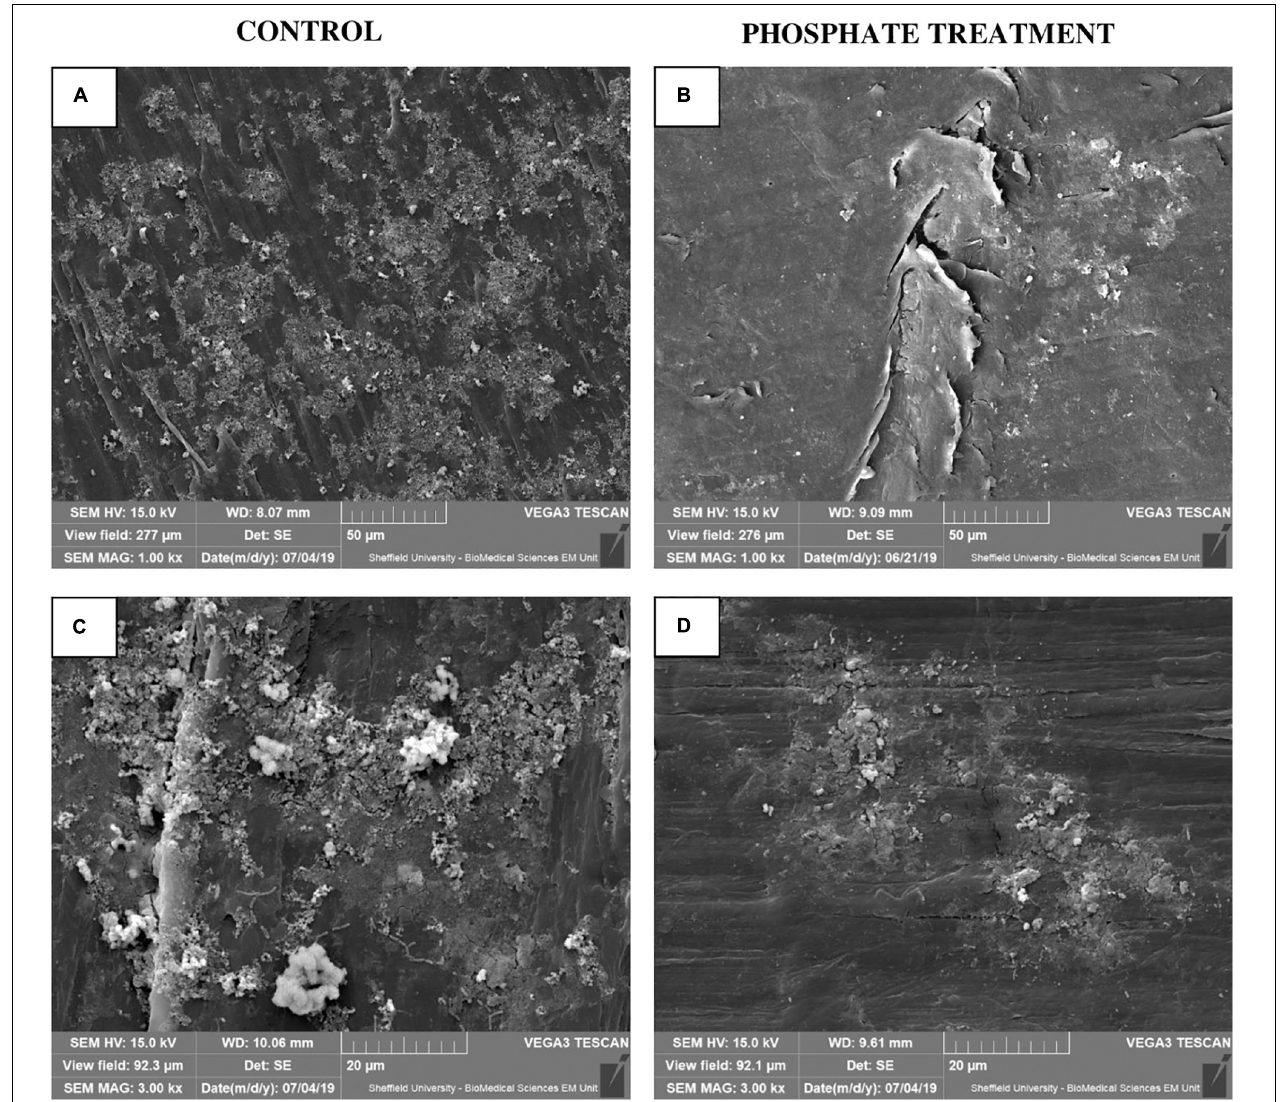
FIGURE 3 | Biofilm micrograph images at 28-day biofilms using SEM ( n = 3). (A,C) show biofilm structure under United Kingdom normal water phosphate concentrations (Control), at 1.00 kx (A) and 3.00 kx (C) SEM magnification. (B,D) show biofilm physical appearance under the effect of 2 mg/l of phosphate (Phosphate treatment) at 1.00 kx (B) and 3.00 kx (D) SEM